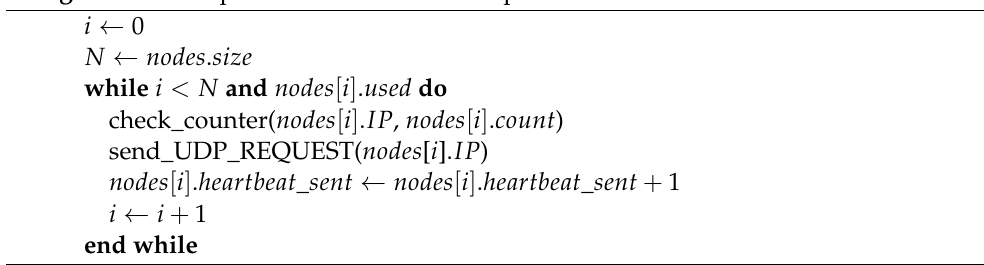
Algorithm 5: Proposed method: Detection phase